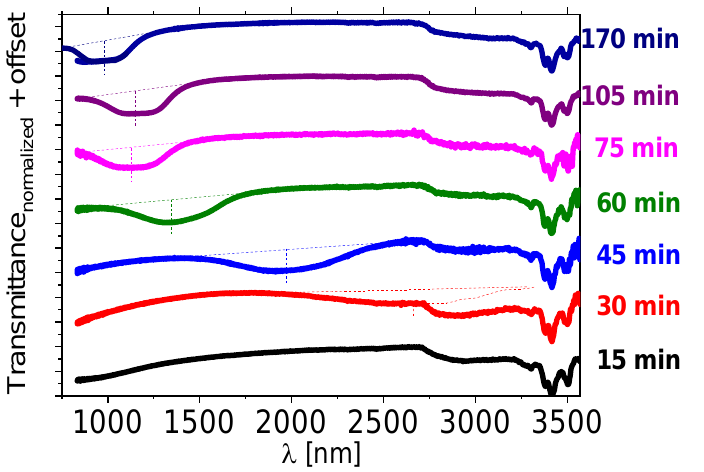
Figure 6. Near-infrared transmission spectra of the isothiocyanate-based multicomponent LC host — 1825 doped with about 10 wt% of the [ N 11116 ][ BNDP ] salt after various heating time at a temperature of 150 ◦ C. For the heating time of 170 min, the result of additional measurement in a range of 750–1100 nm by another UV-Vis-NIR spectrometer is presented by individual lines of the same color. Dotted lines were sketched to indicate estimated shapes and position of the center of the reflection bands.